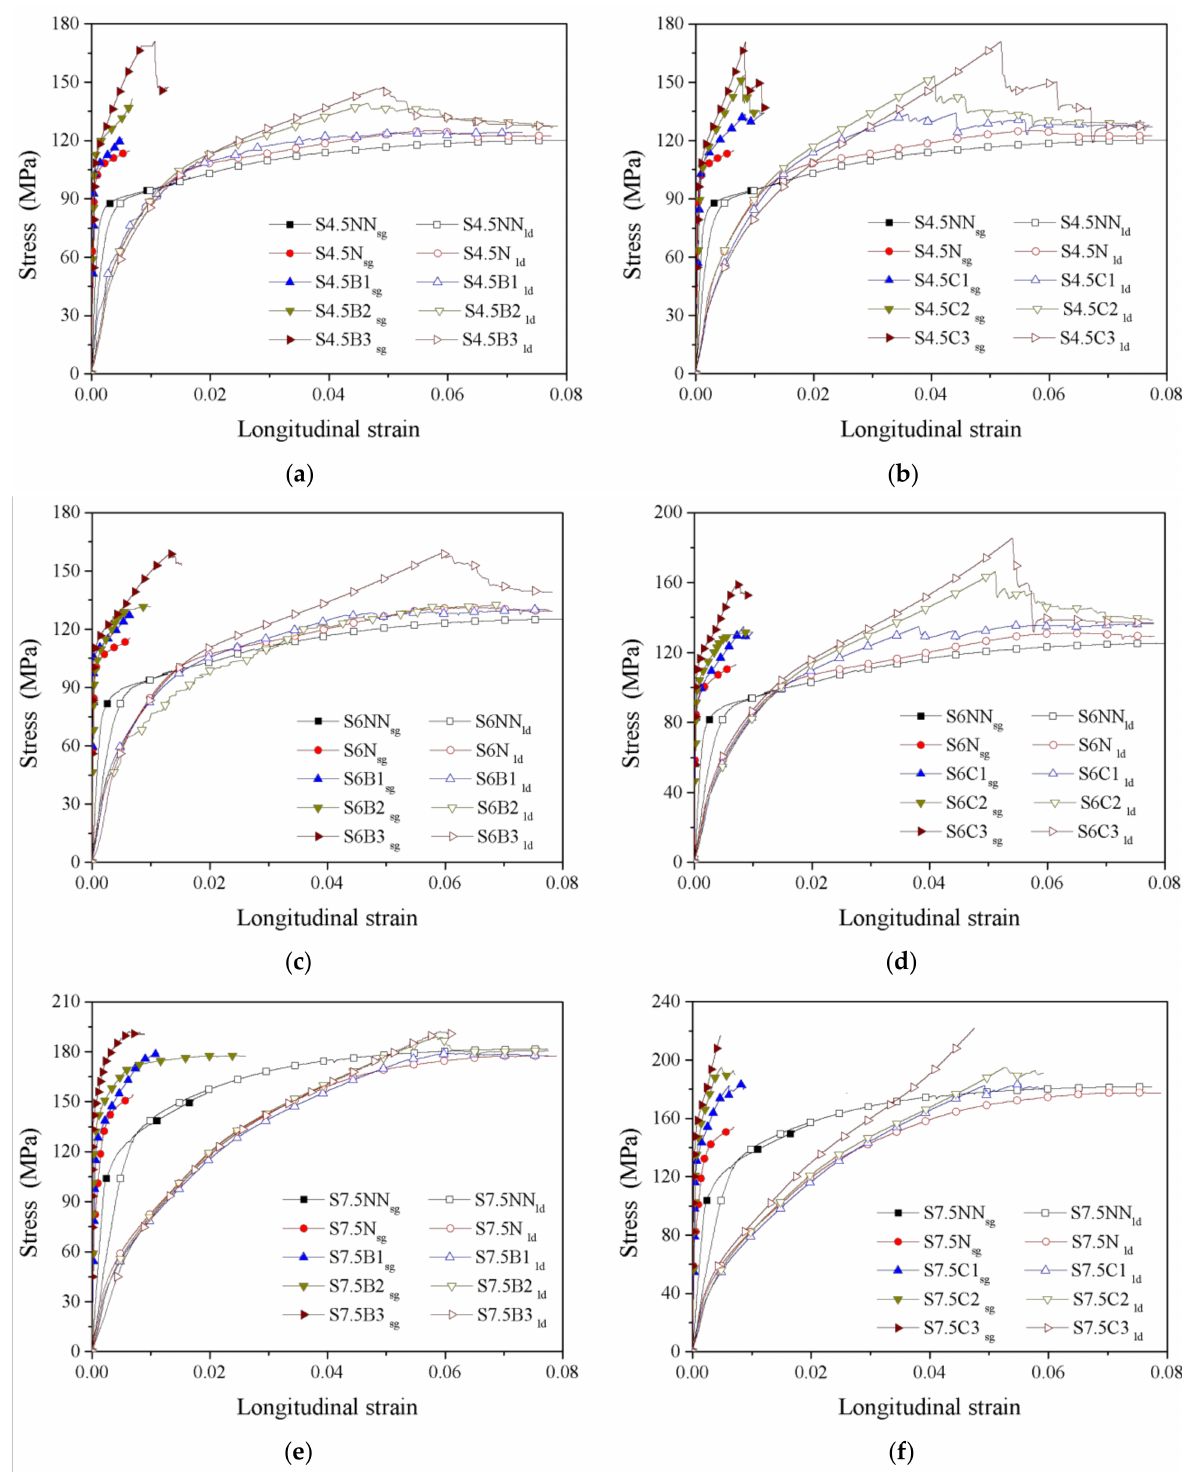
Figure 7. Comparison of the stress-overall strain and stress-local strain curves. ( a ) S4.5B series. ( b ) S4.5C series. ( c ) S6B series. ( d ) S6C series. ( e ) S7.5B series. ( f ) S7.5C